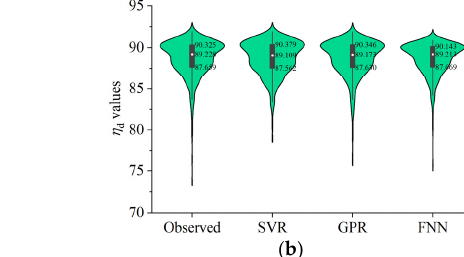
Machines 2022 , 10 , x FOR PEER REVIEW 12 of 21 Figure 8. PDF of predicted and observed values: ( a ) H ip 2 and ( b ) η d . Figure 8. PDF of predicted and observed values: ( a ) H ip 2 and ( b ) η d .